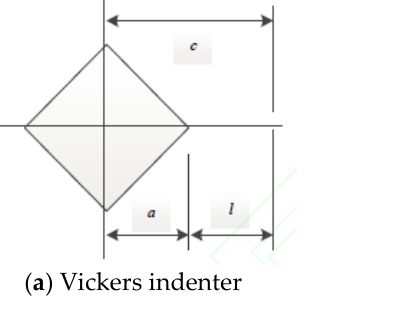
Figure 3. Schematic diagram of radial crack with two indenters.